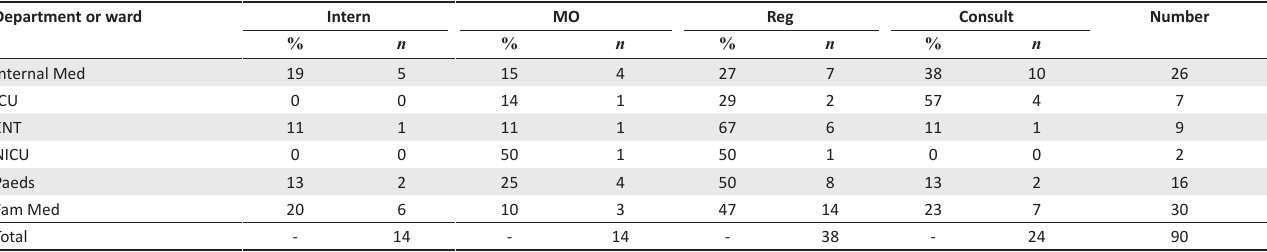
TABLE 1: Description of the research